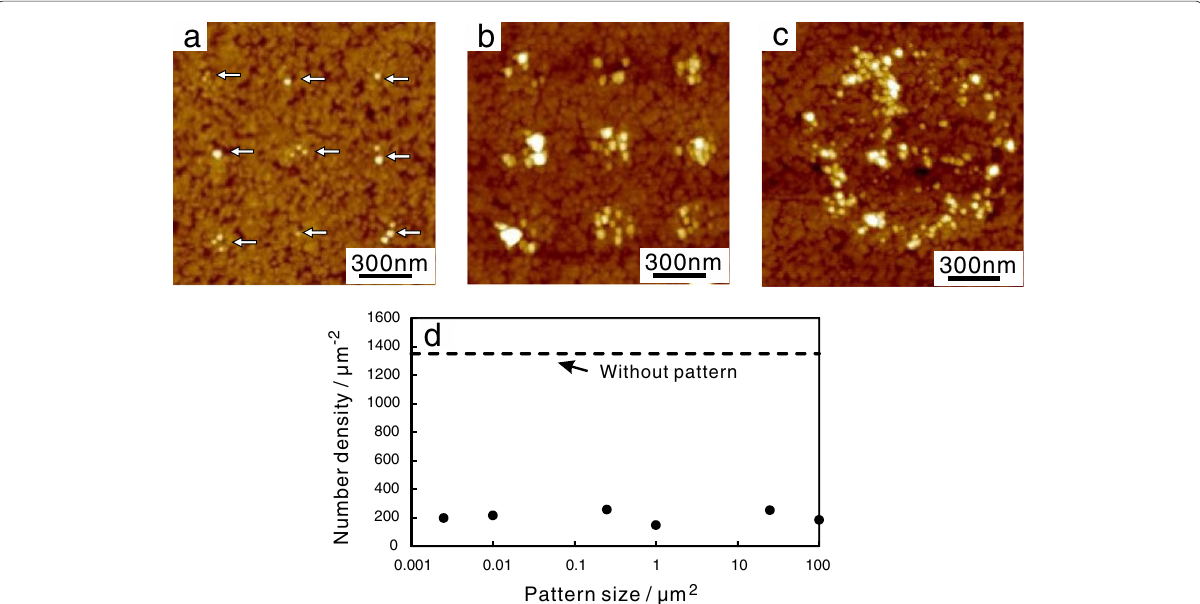
Fig.5 AFM images of QDs on the dotpatterns . The designed dotsizes were 50 nm ( a ), 100 nm ( b ), and 500 nm ( c ). Immobilized QDs are indicated with whitearrows in a . d Number density of QDs on the dotpatterns . Dashedline represents the number density of QDs on the Au surface